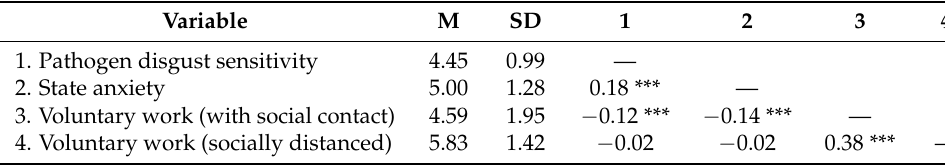
Table 2. Zero-order correlations among the primary variables.